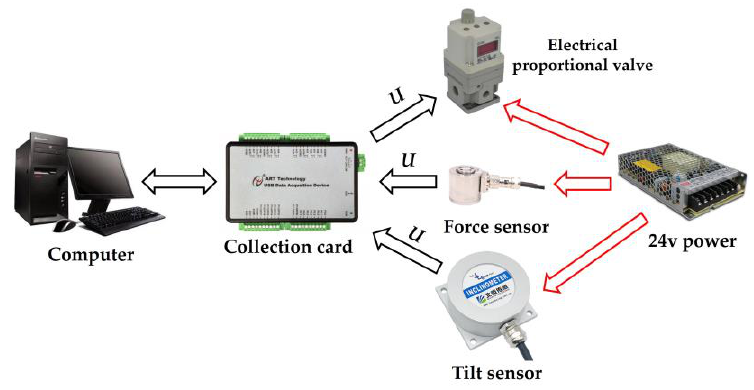
Figure 2. Circuit communication of the force-controlled